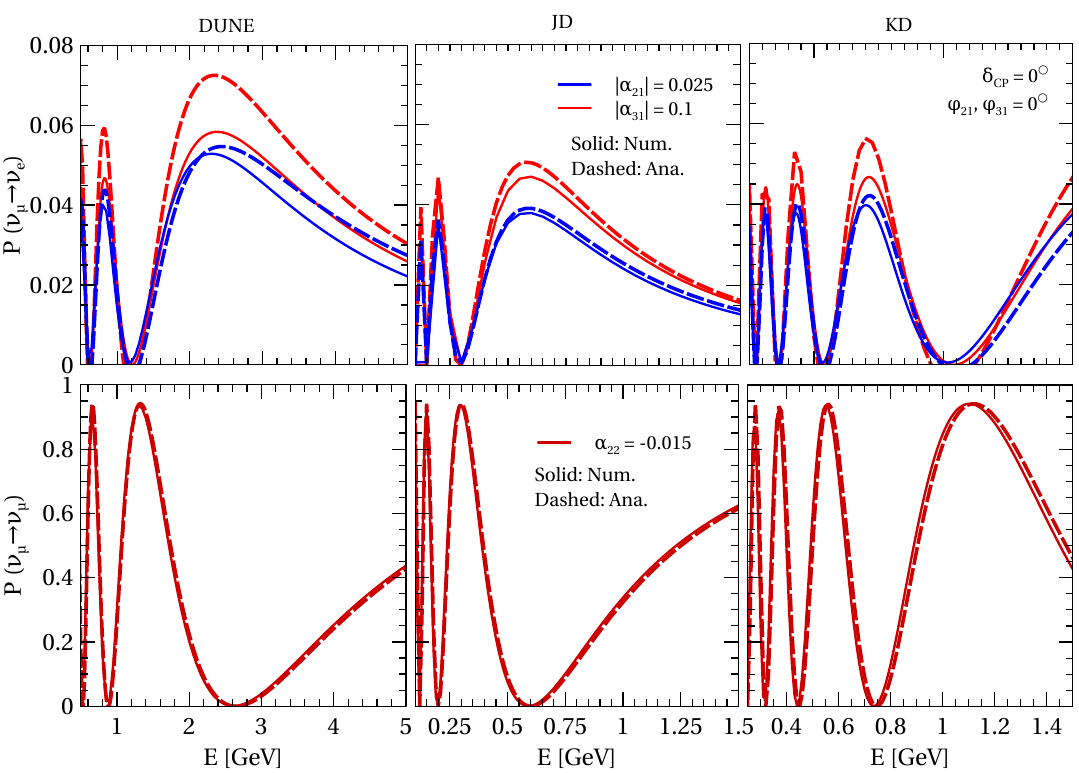
Figure 9 . Upper panels show the ν µ → ν e appearance probability in presence of the NUNM pa- rameters | α = 0 . 025 and | α = 0 . 1 . Lower panels depict the ν disappearance probability 21 | 31 | µ → ν µ for α = 0 . 015 . Left, middle, and right columns correspond to the baselines of 1300 km (DUNE), 22 295 km (JD), and 1100 km (KD), respectively. Solid curves in each panel show the oscillation prob- abilities obtained numerically, while the dashed curves are the probabilities obtained analytically using eq. (2.6) and eq. (2.9). We consider the values of δ and the phases φ , φ equal to zero. CP 21 31 The values of the other standard oscillation parameters are taken from table